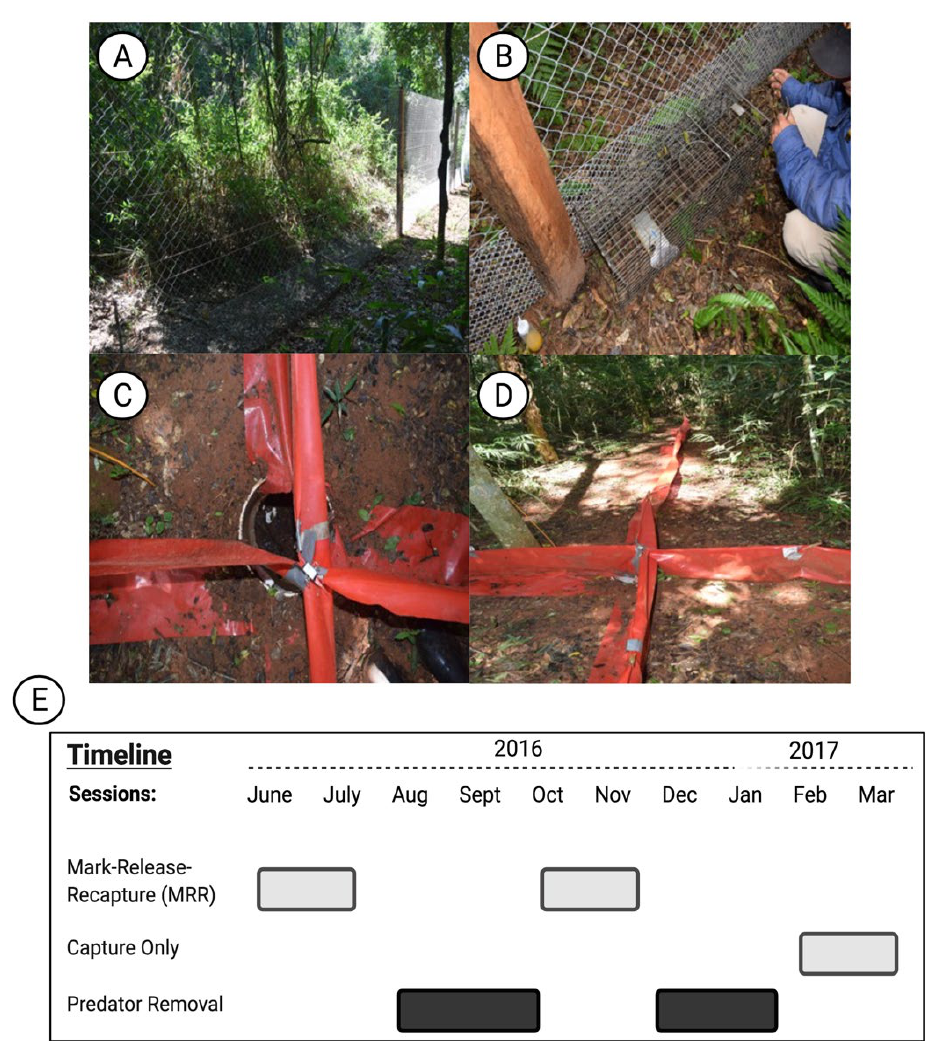
Figure 2. Experimental field design. ( A ) Photo taken of the two-meter-high chain link fencing that was constructed on the three experimental grids—H, D, C. ( B ). Cage trap placed against the inside of the fences, also showing the half-meter high small-mesh chain link fencing. ( C ) Pitfall trap used to capture small terrestrial mammalian predators. ( D ) Image of four 5 m drift fences extending in